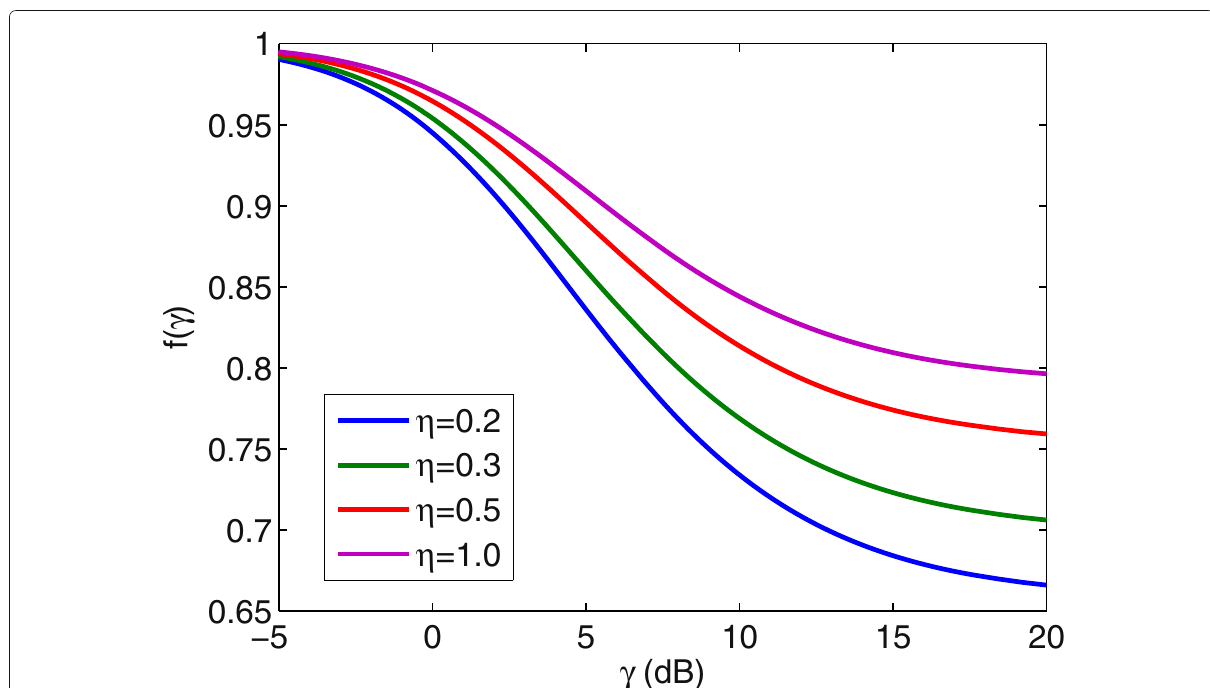
Fig. 1 Curves of the rational function f (γ) , as a function of SNR γ (dB), for fading model η − μ with μ = 0.6 for 64-QAM and different values of η